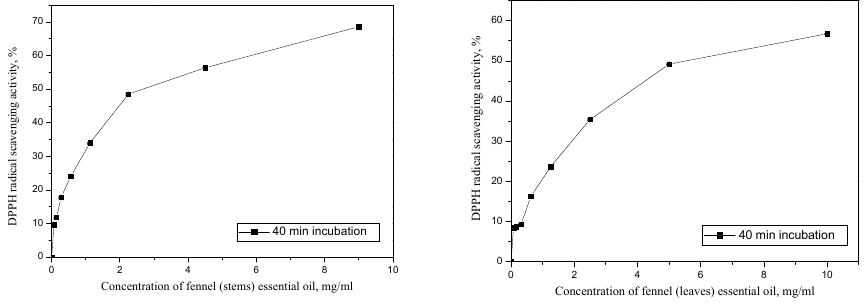
Figure 5. Antioxidant activity of wild fennel stems and leaves essential oil.